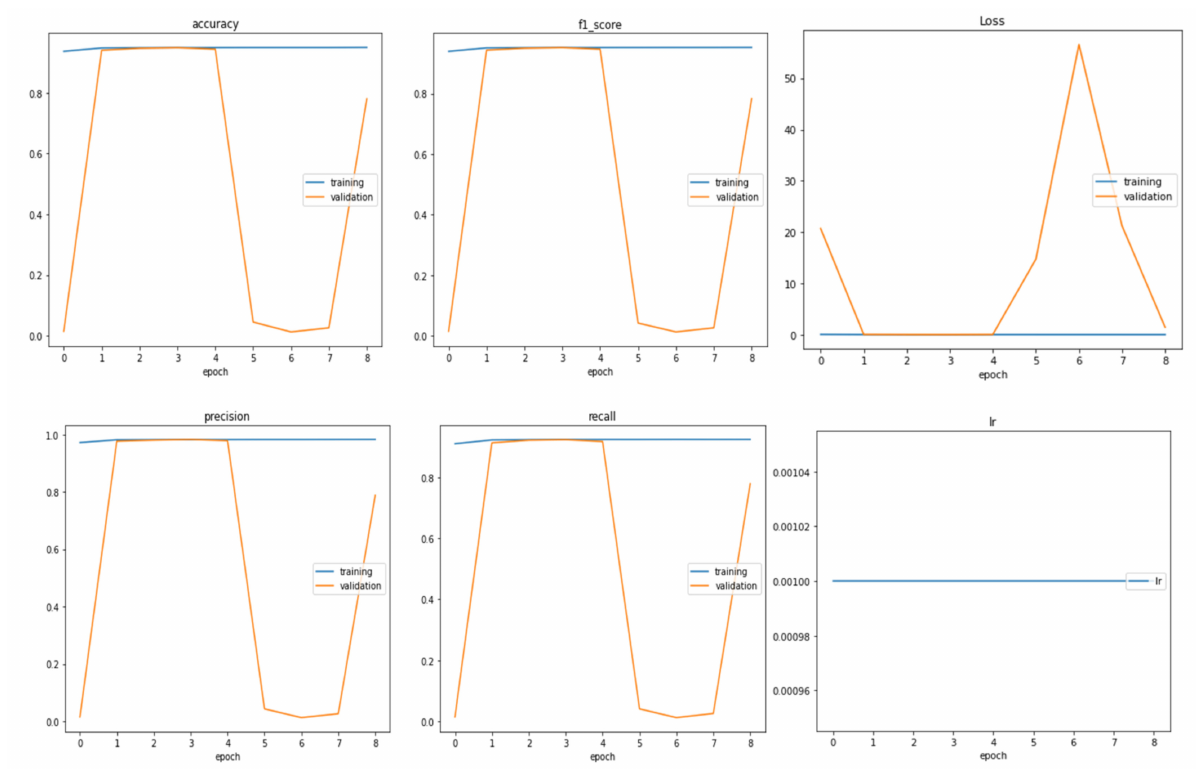
Figure 13. The training and validation accuracy, F1-score, loss, recall, and precision after training the Inception Time model on the Edge-IIoT dataset.